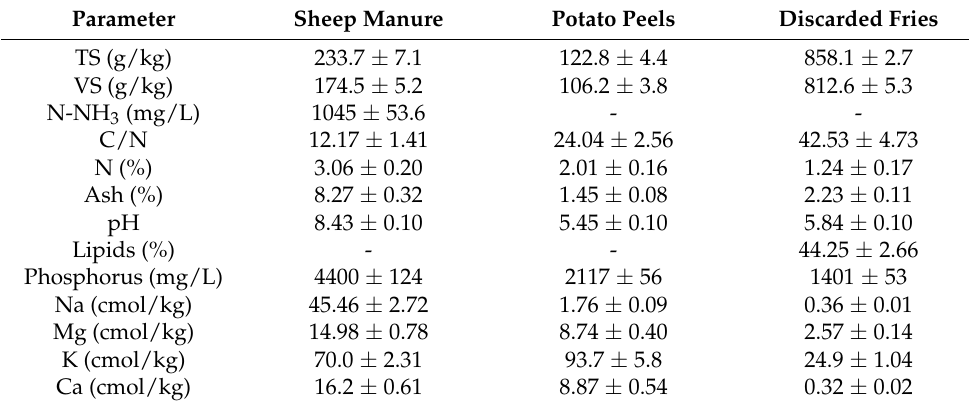
Table 1. Characterization of substrates used in this